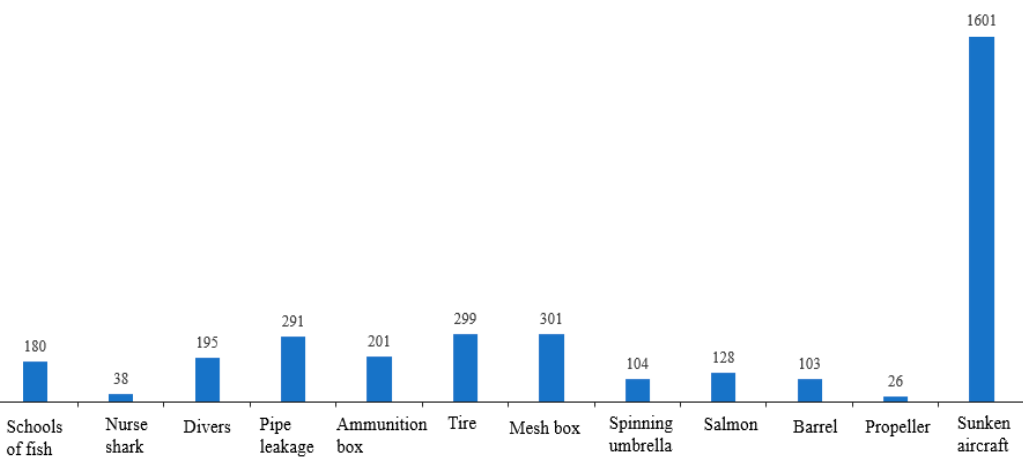
Figure 12. Number of images per segmentation class.